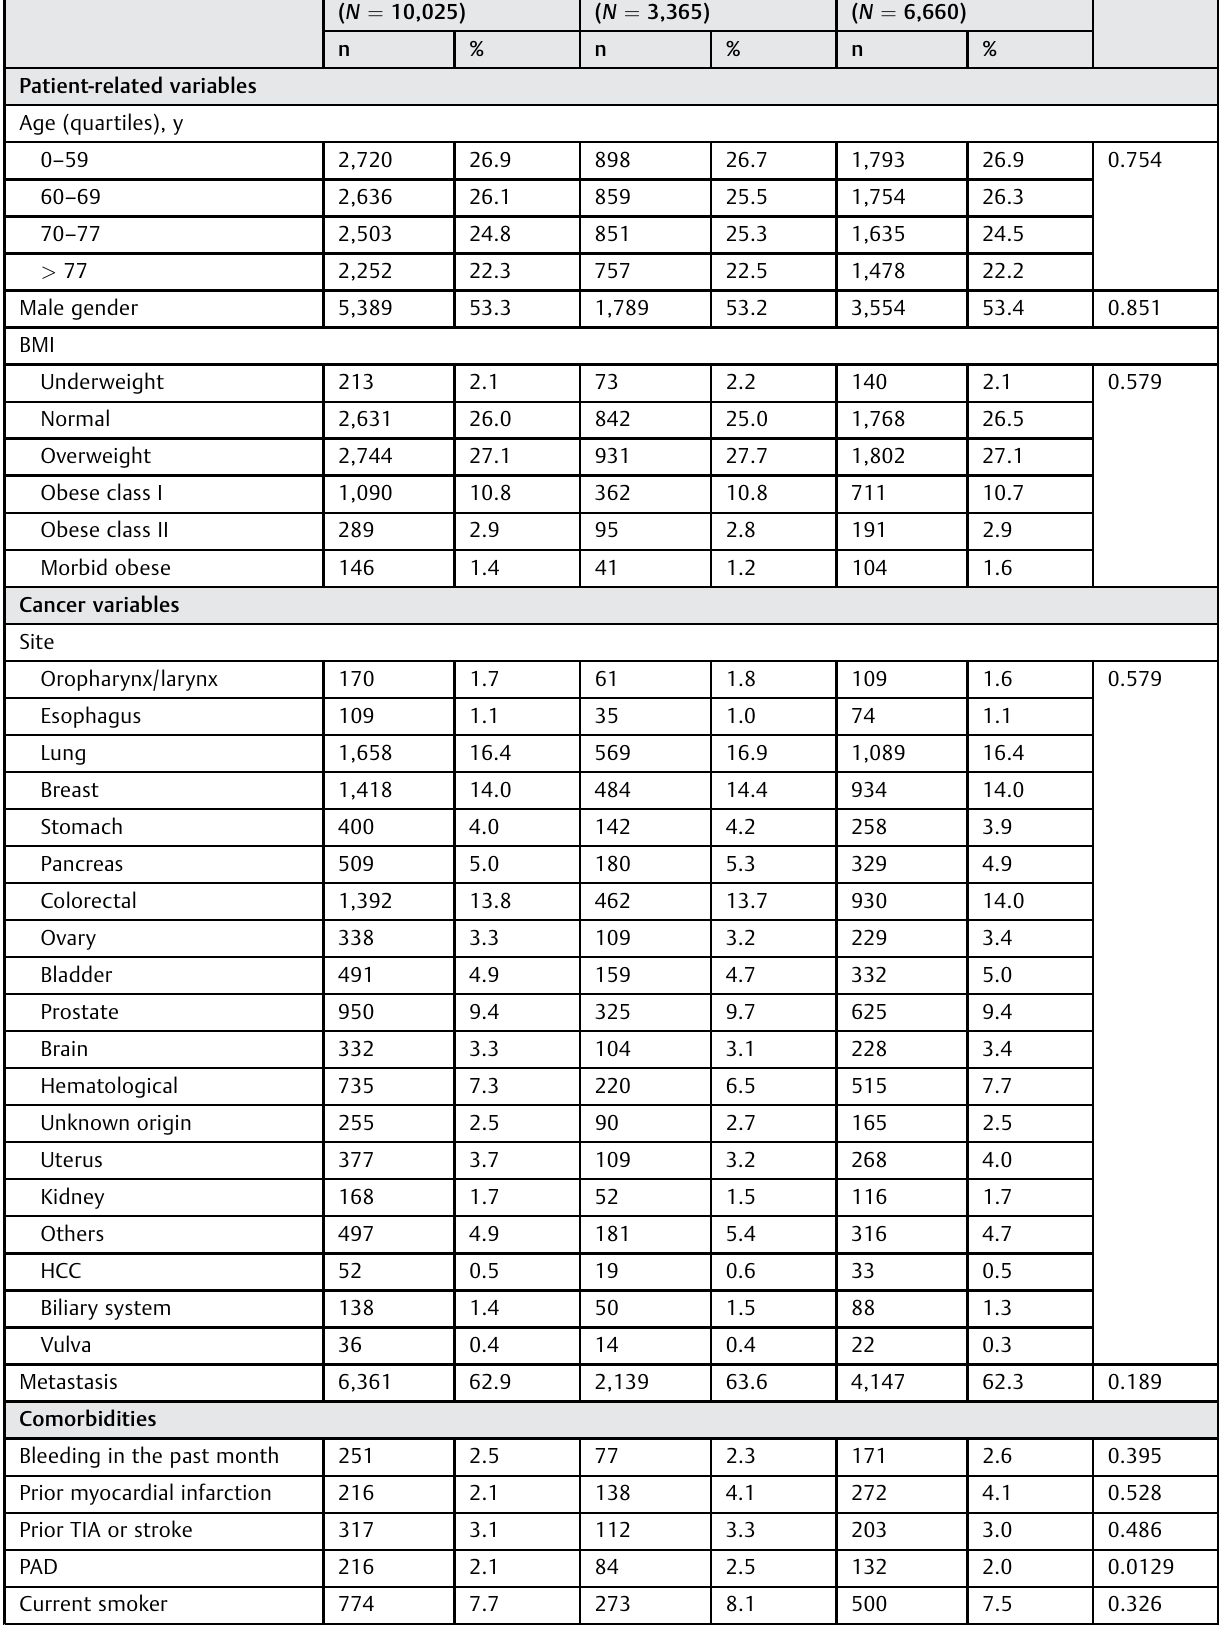
Table 1 Baseline characteristics of the